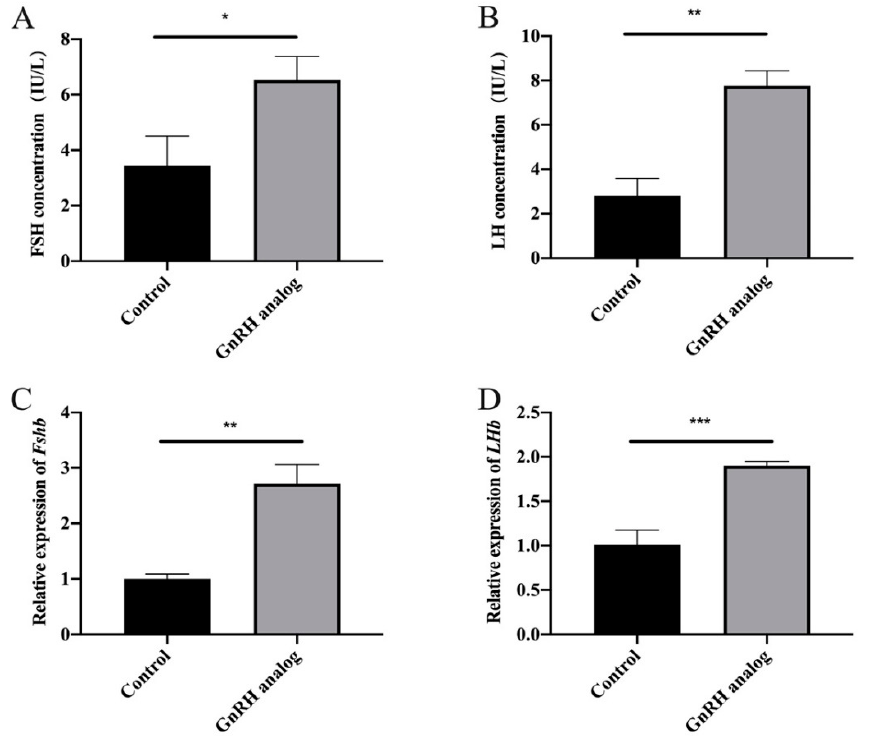
Figure 3. Low-frequency GnRH analogue treatment promoted the synthesis and secretion of FSH and LH in rats. ( A , B ) The secretion levels of FSH and LH after treatment with the GnRH analogue. ( C , D ) The expression of Fsh β mRNA and Lh β mRNA after treatment with the GnRH analogue. All experiments were repeated at least three times. Data are presented as the means ± SD. p < 0.05 was considered significant, and the differences are marked with the symbol *. When p < 0.01, ** was used to show the significance of the difference. When p < 0.001, *** was used to show the significance of the difference.